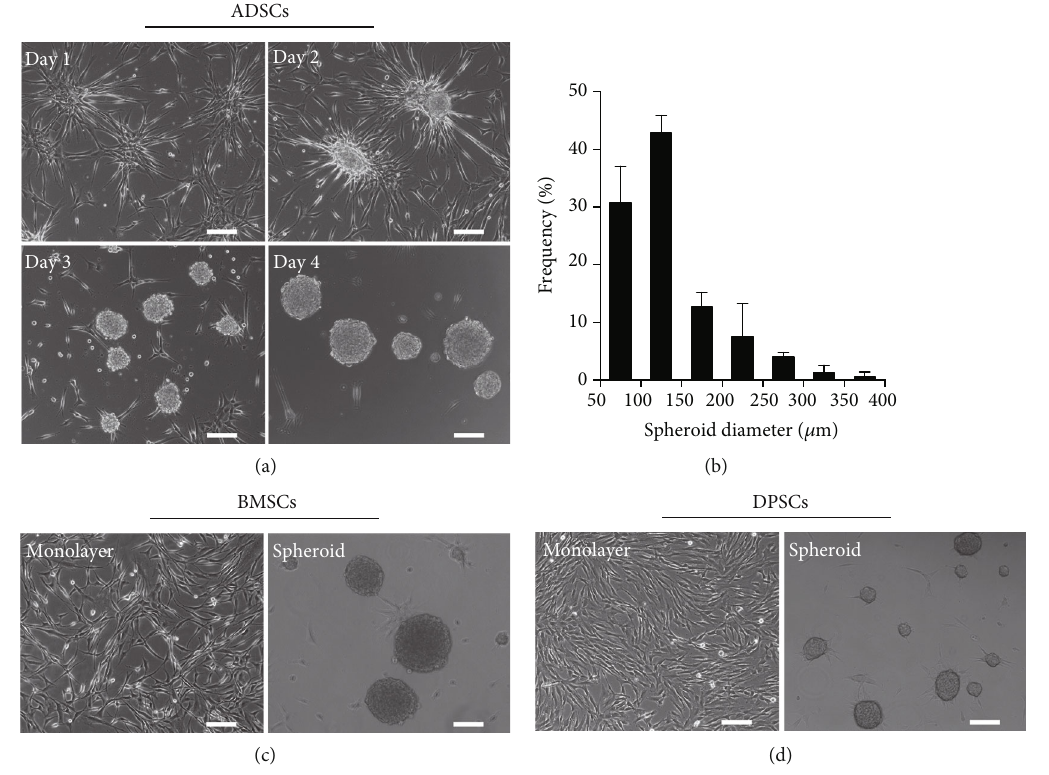
Figure 1: MSCs spontaneously form spheroids in TeSR-E8 medium on tissue culture dishes. (a) Phase contrast images showing the time- course of ADSC spheroid formation over 4 days. Scale bar: 150 μ m. (b) Size distribution of ADSC spheroids on day 4 postculture. (c, d) Morphology of monolayer and spheroid BMSCs and DPSCs. Scale bar: 150 μ